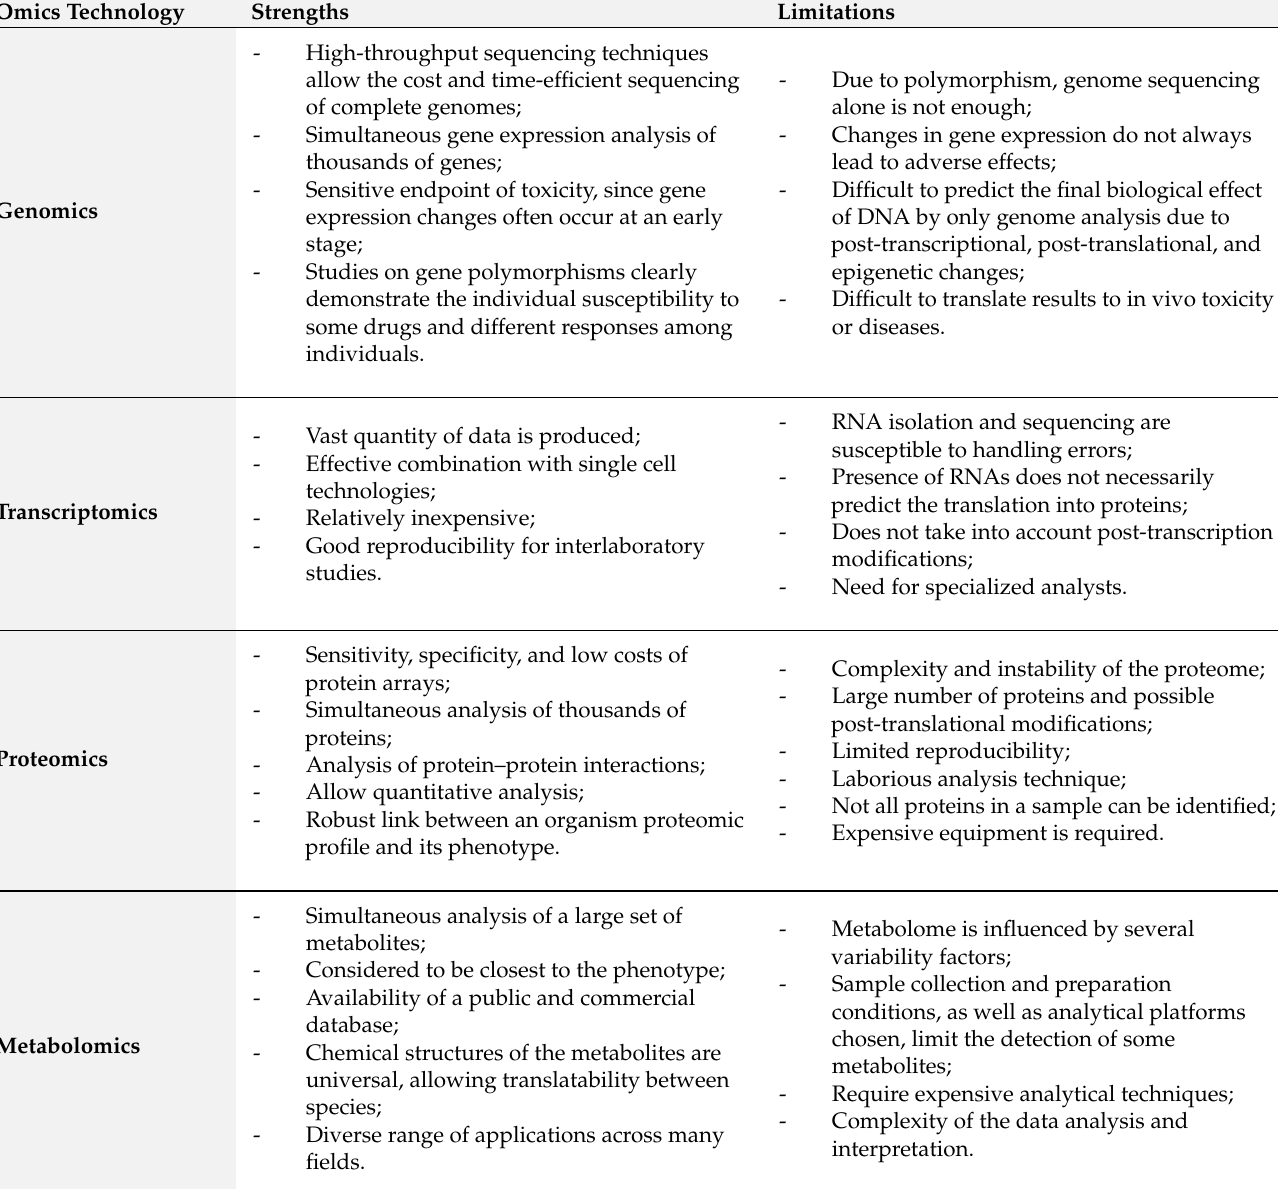
Table 1. Advantages and limitations of different omics technologies (adapted from [21]). Omics